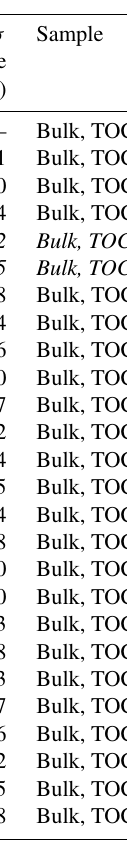
Table 1. Radiocarbon dates from sediment core EN18218. Calibrated median ages and 2 σ confidence intervals were calculated with CALIB 8.2 (Stuiver et al., 2020) using the IntCal20 (Reimer et al., 2020) calibration curve. Calibrated ages are given as calibrated years before the present (years before 1950CE, kacalBP). The surface sample used for down-core correction of the reservoir effect was not calibrated. Samples in italic and marked with an asterisk ( ∗ ) were excluded from the age-depth